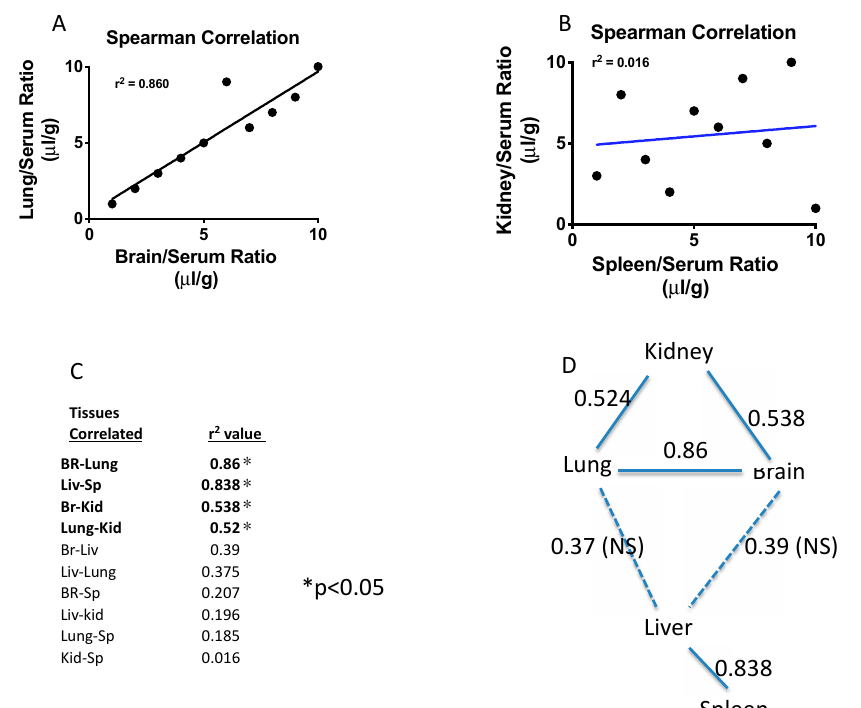
Figure 6. Path analysis for tissues. In ( A , B ), examples of correlations of the ten exosomes among paired tissues. In ( C ), a list of all r 2 values for various combinations of tissues. * indicates those paired tissues that showed a statistically significant correlation. In ( D ), the path analysis for the five tissues studied. Liver-spleen form one strongly related cluster, whereas lung-brain show a second strongly related cluster, with kidney also correlated to lung and brain.